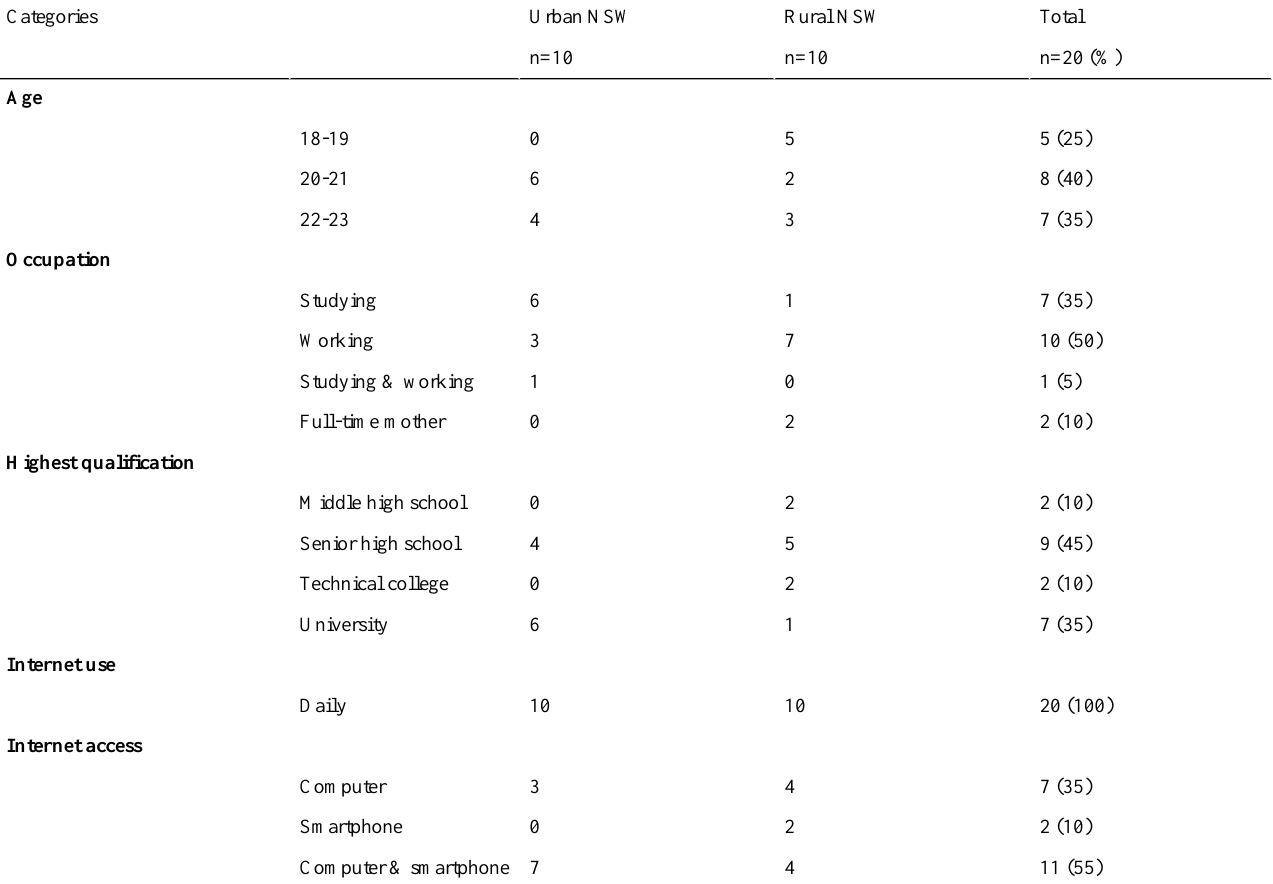
Table 1. Characteristics of participants living in New South Wales (NSW,